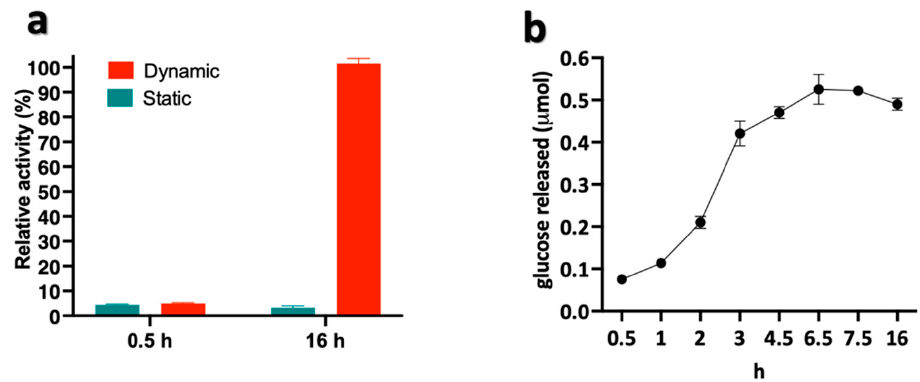
Figure 2. C200 sample treated with Cellic Ctec2. ( a ) Enzymatic hydrolysis under dynamic and static conditions; ( b ) Kinetic analysis of degradation process under dynamic conditions.